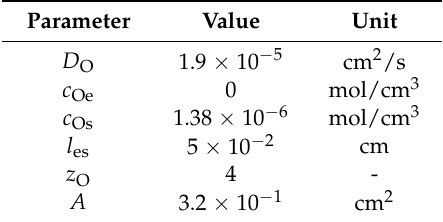
Figure 5. Salt water droplet on the sensor surface and the initial corrosion current. Table 1. Parameters for calculation of the maximum initial current.